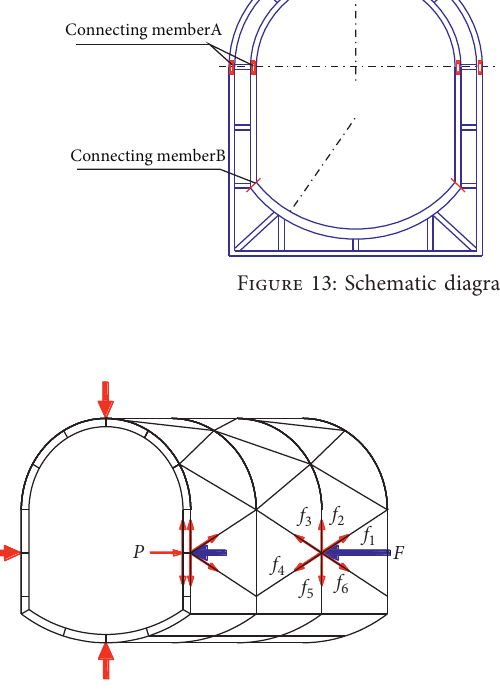
Figure 14: Stress analysis of a flexible truss support